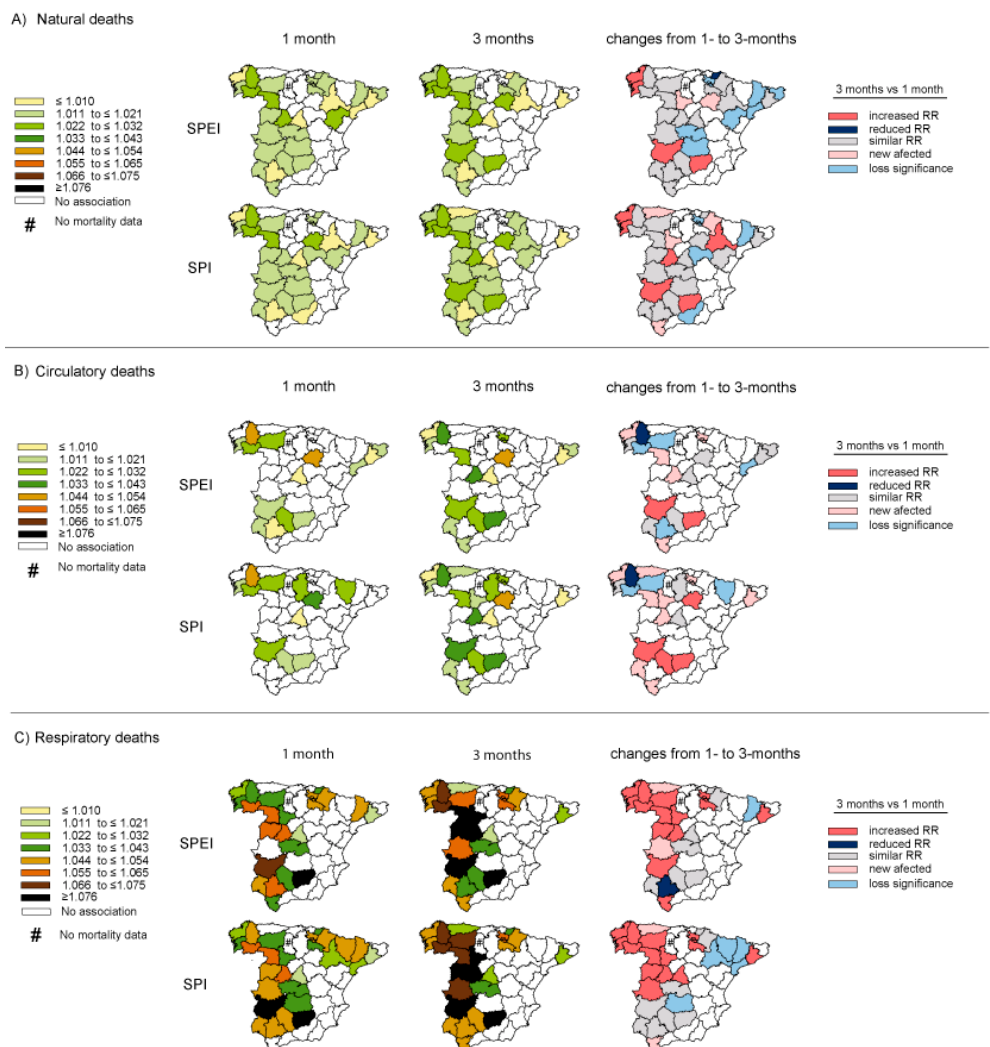
Figure 2. Relative risks (RRs) (95% CI) of daily mortality linked to drought conditions.Comparison of the provincial RRs of daily mortality associated with drought measured at di ff erent timescales. RR values for daily ( A ) natural, ( B ) circulatory, and ( C ) respiratory mortality linked to droughts measured by the Standardized Precipitation Evapotranspiration Index (SPEI) and the Standardized Precipitation Index (SPI) calculated for short (one month, left-hand column) and short–medium (three months, center column) timescales. The right-hand column provides a comparison of the di ff erences among them. RR values for SPEI-1 and SPI-1 weretaken from Salvador et al. (2020) [29]. Complete statistical information is provided in the Supplementary Material (Figures